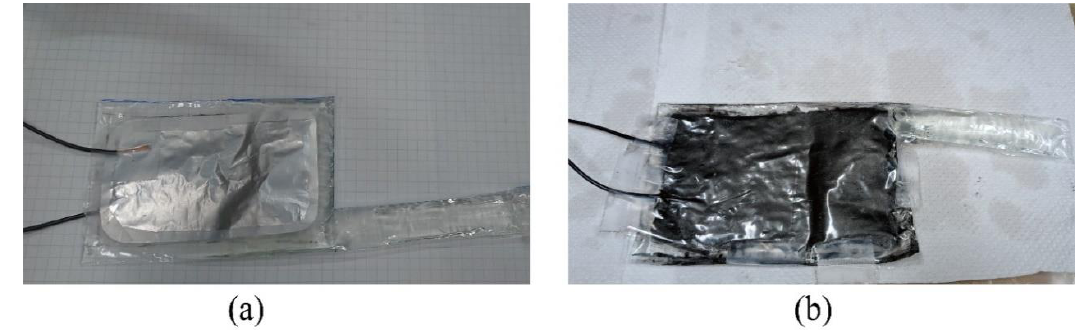
Figure 16. Comparisons of compliant electrodes made of ( a ) aluminum foil and ( b ) carbon powder paste.